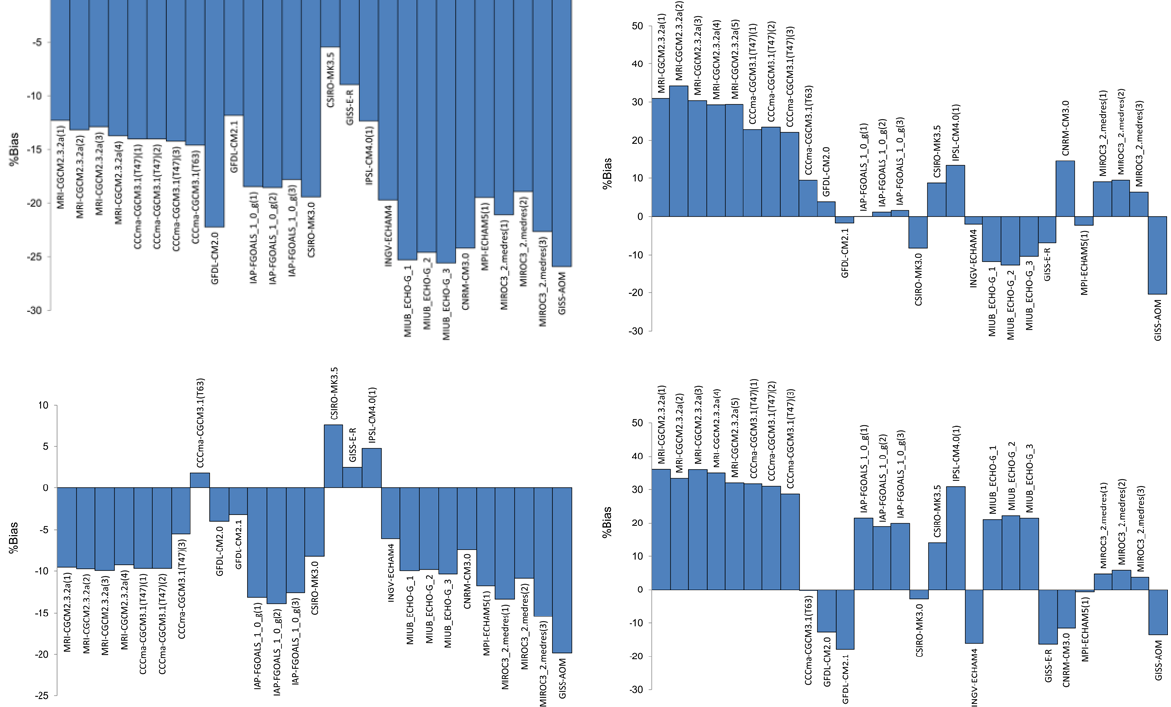
Fig. 8. Bias of daily maximum temperature for winter (top) and summer (bottom) seasons at Kisumu (left) and Bahirdar